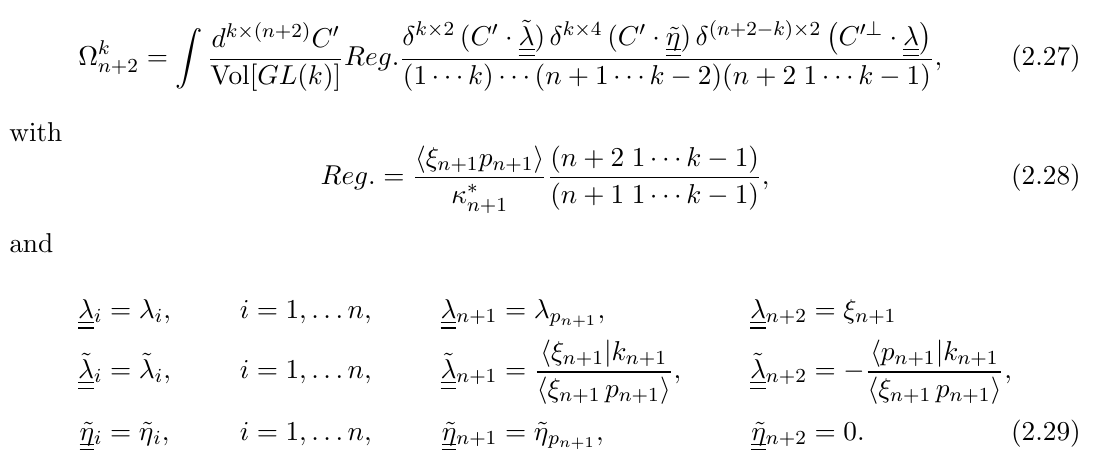
Figure 1 . The action of Br ( i, i + 1) operator on the on-shell diagram. White blob is MHV amplitude, black one — MHV 3